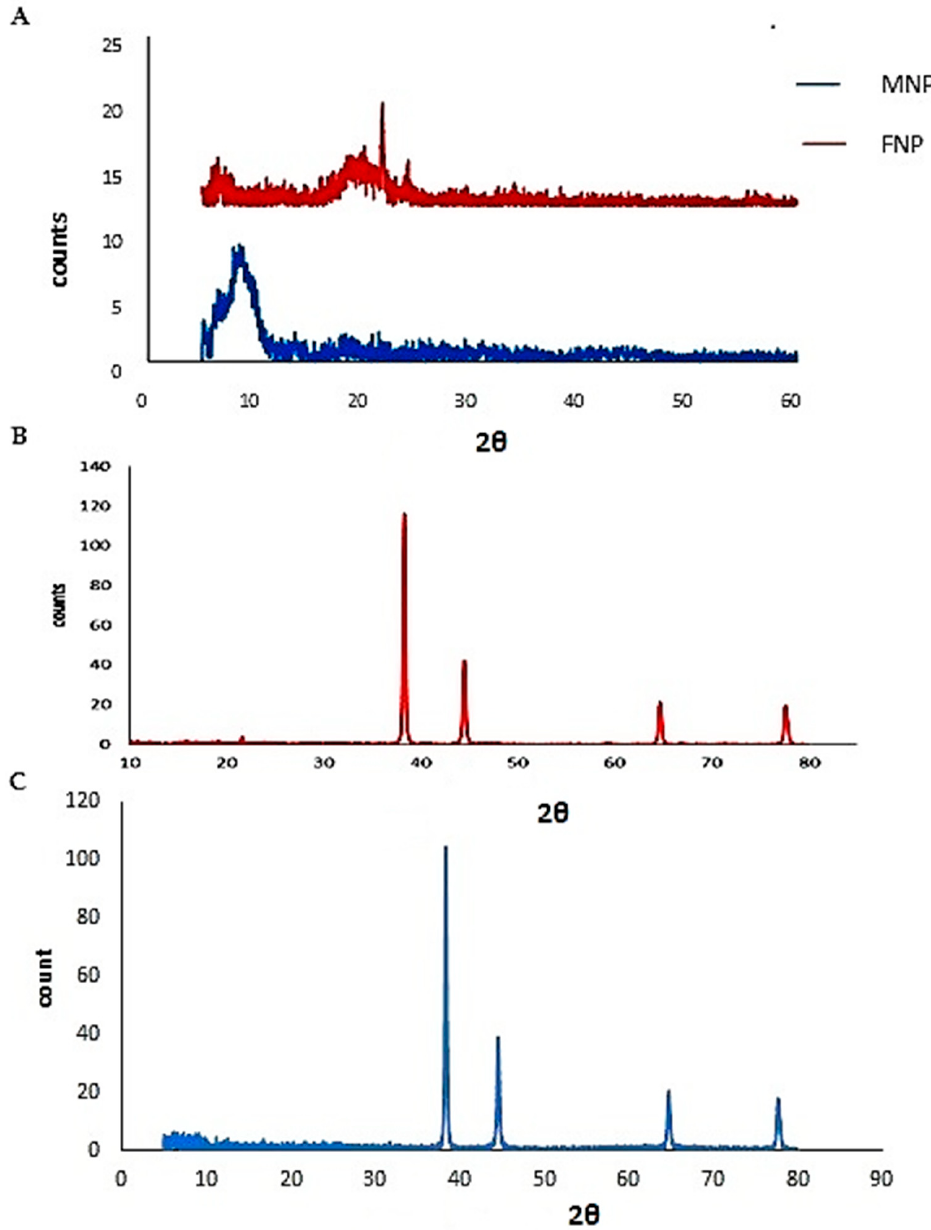
Figure 2. Powder X-ray Diffraction (XRD) pattern for ( A ) MNP and FNP, ( B ) Ag-FNP, and ( C ) Ag-MNP.